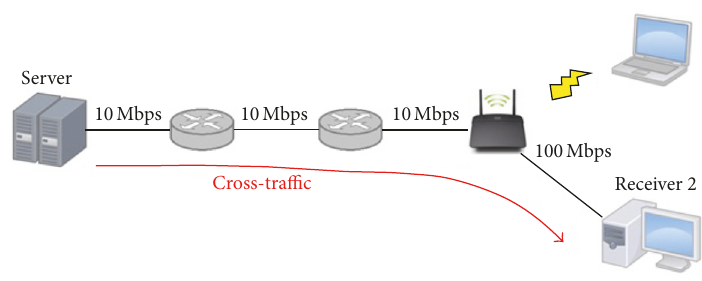
Figure 12: Experimental network scenario 2.